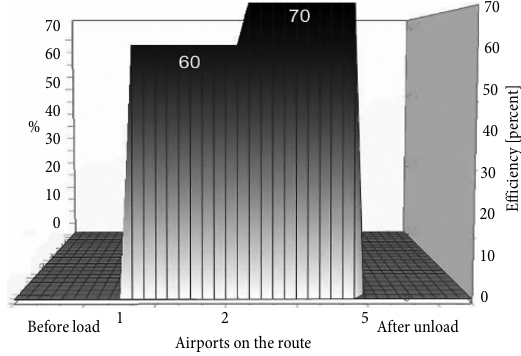
Fig. 4. Efficiency of the